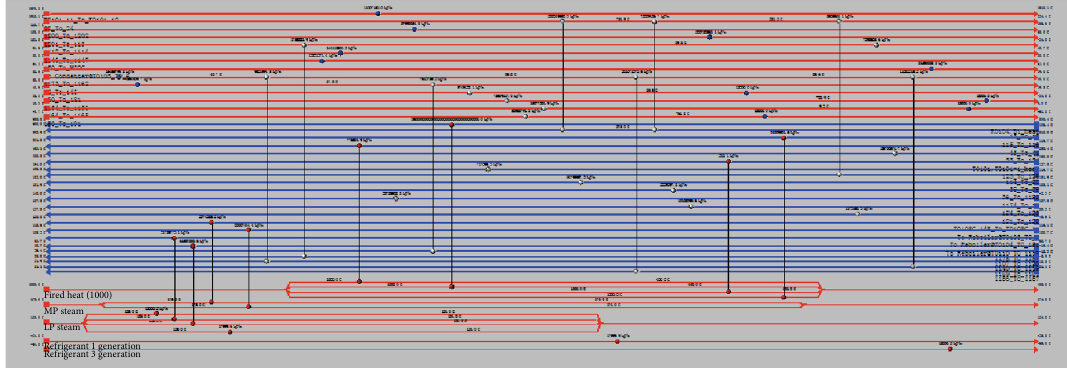
Figure 6: Optimized network of heat exchangers.